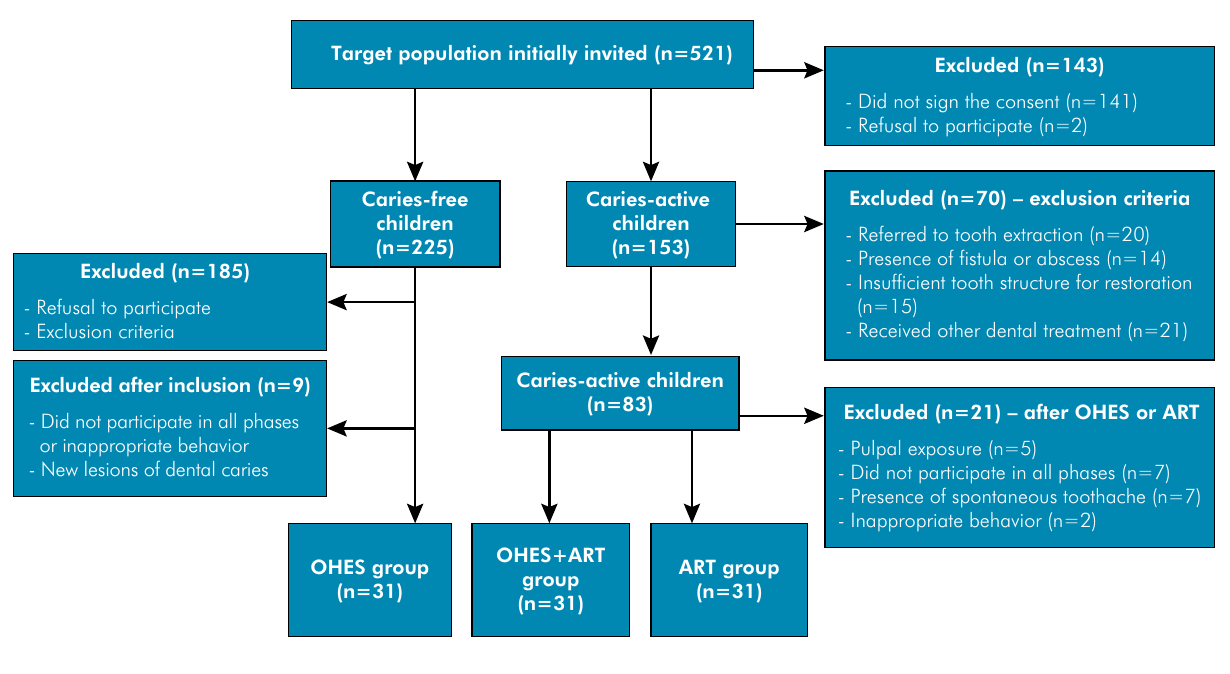
Figure 1. Flowchart of sample selection, allocation in groups, and description of the interventions (OHES: oral health educational strategy; ART: atraumatic restorative